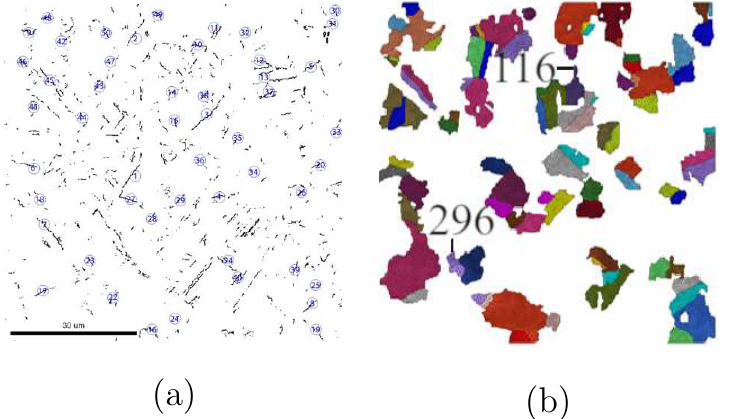
Fig. 12: (a) Measured grain boundaries of Σ3-twins and se- Figure 12. (a) Measured grain boundaries of Σ 3-twins and selected 50 pairs of twins; ( b ) correspond- ing grains of the marked 50 pairs of Σ 3-twins in ( a ). lected 50 pairs of twins; (b) corresponding grains of the marked 50 pairs of Σ3-twins in (a).